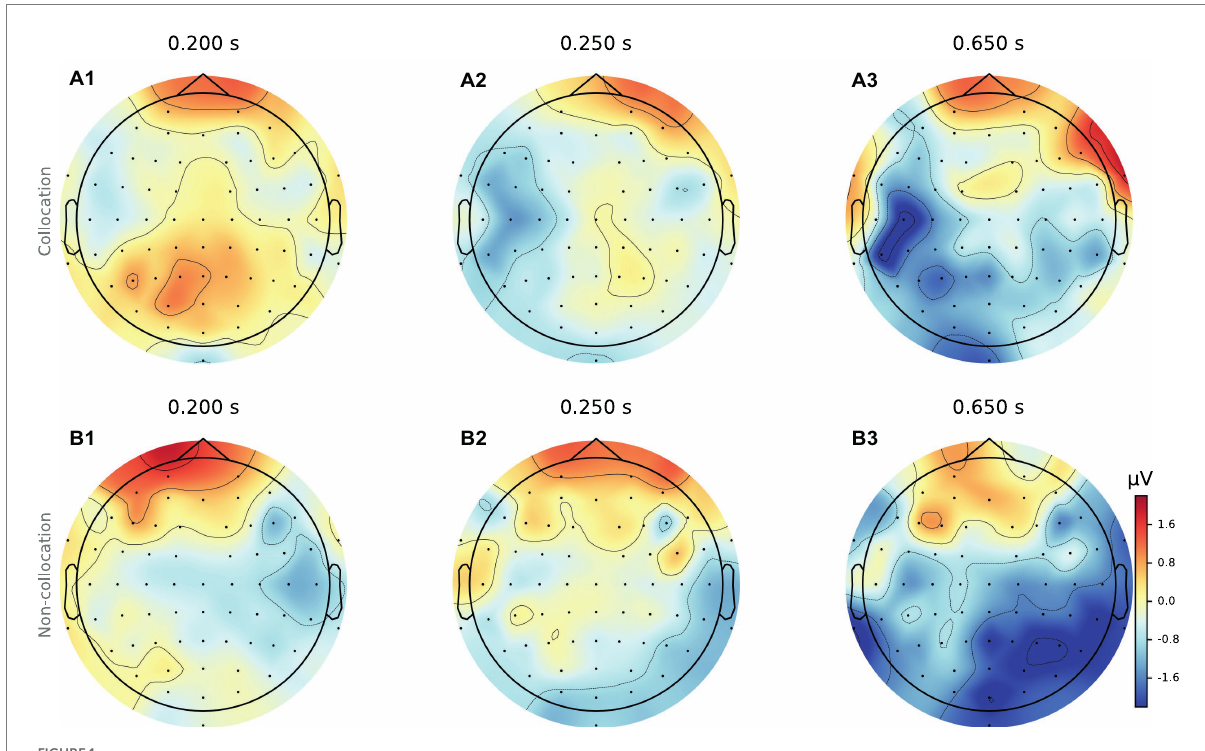
FIGURE 1 Topomaps of grand averages for collocations and non-collocations. The surface plots show the averaged neural signal (neural activity) of the cerebral cortex averaged over 31 participants for collocations (a1-a3) and non-collocations (b1-b3) stimulation at three different time points (latencies: 200 ms, 250 ms, 650 ms). Collocation (blue) vs. non-collocation